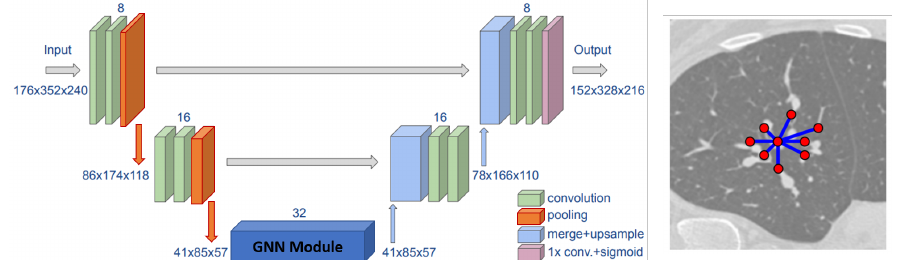
Figure 12. Schematic of a UNet-GNN and illustration of irregular node connectivity for a given voxel in the initial graph. Image adapted from [41].